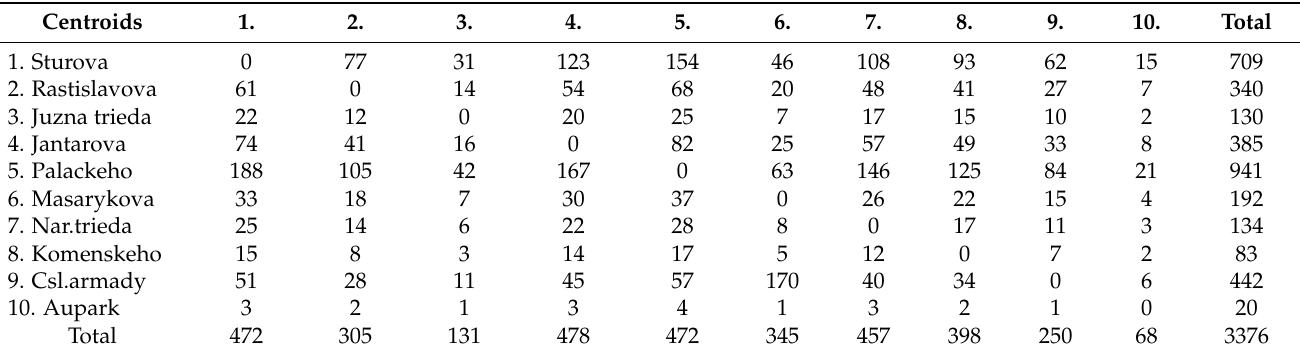
Table 8. Historical matrix for Variant A, (source elaborated by authors).